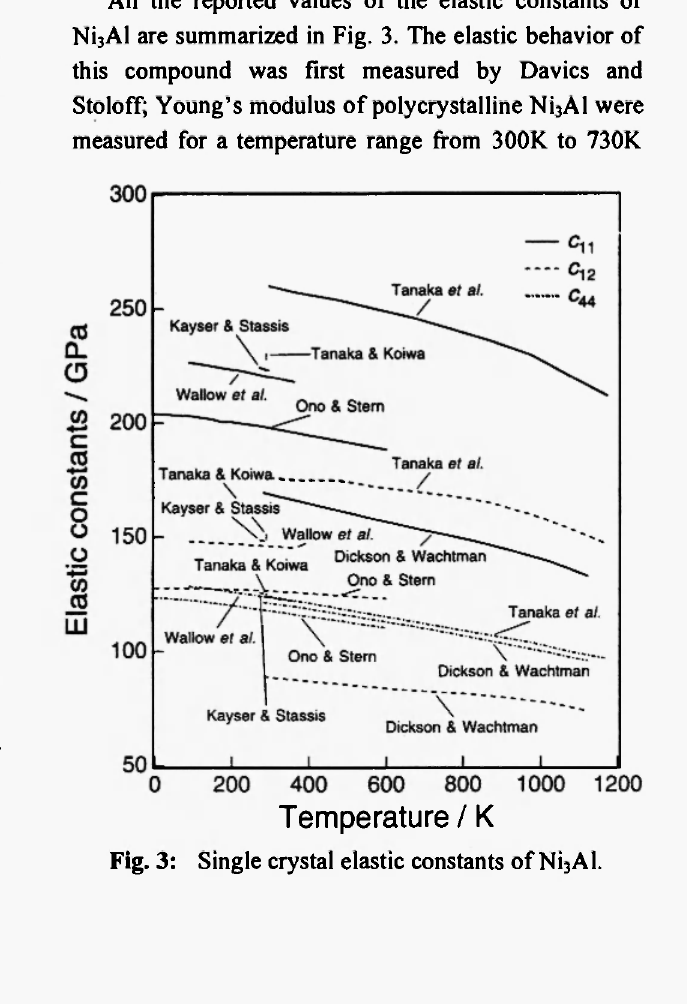
Fig. 3: Single crystal elastic constants of Ni 3